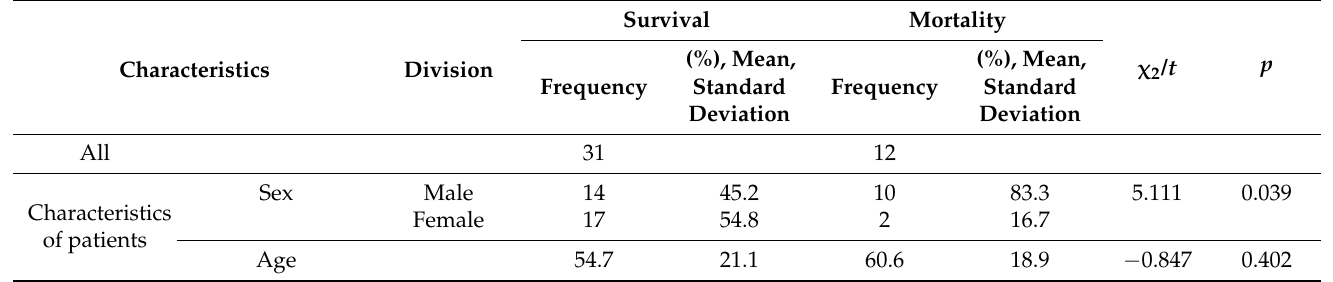
Table 3. Characteristics of patients who attempted self-harm in the hospital setting by treatment